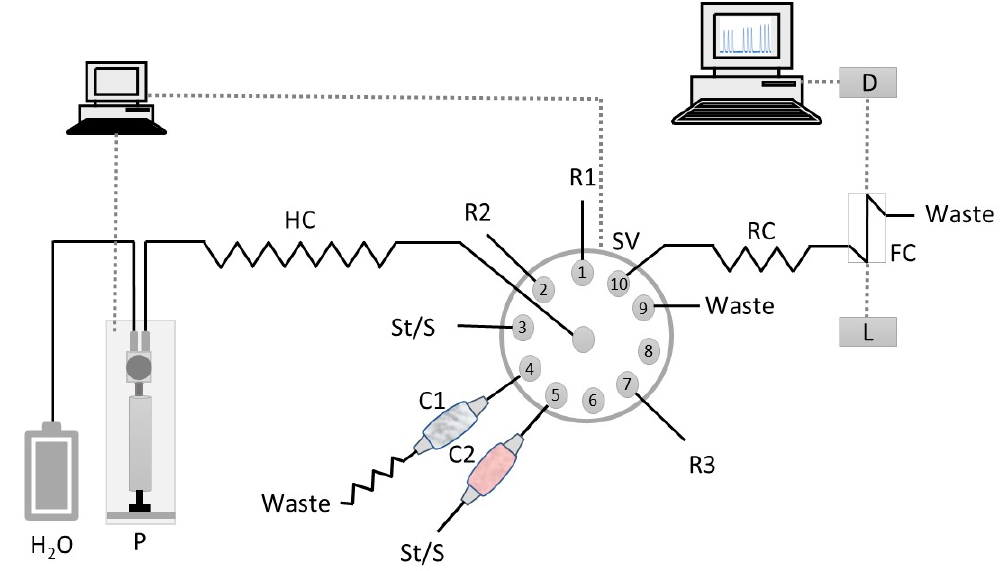
Figure 2. Flow manifold for Cu(II) and Zn(II) determination in waters and soil leachates. St / S, standard solution or sample; R1, PAR reagent (25 µ mol L − 1 ); R2, boric acid bu ff er solution (pH 11); R3– nitric